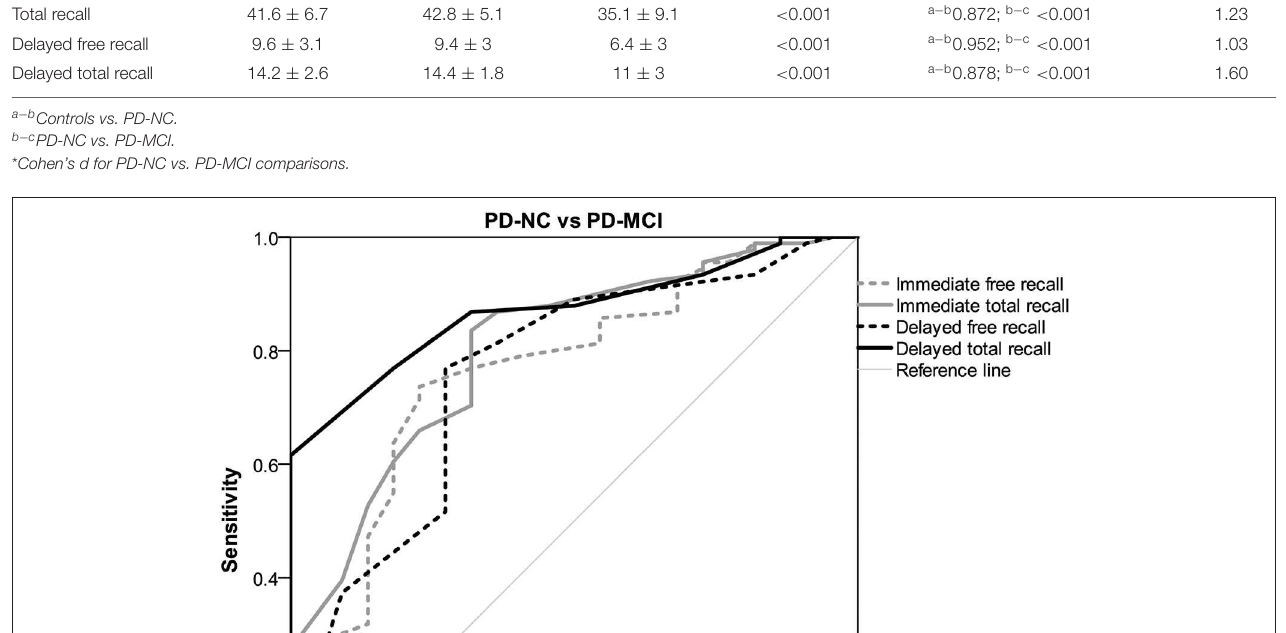
Frontiers in Neurology |